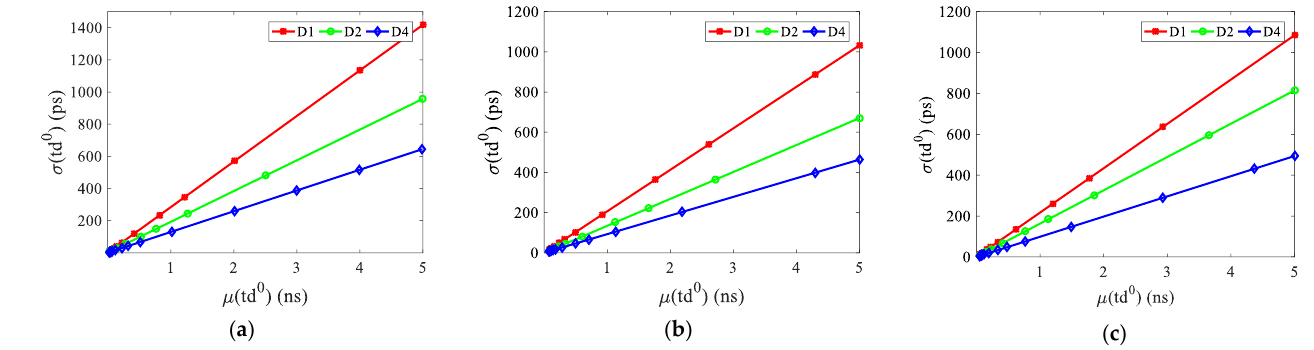
Figure 4. Verification of step delay variation model for different loads by simulation results for ( a ) inverter, ( b ) NAND gate and ( c ) NOR gate. ( a ) inverter, ( b ) NAND gate and ( c ) NOR